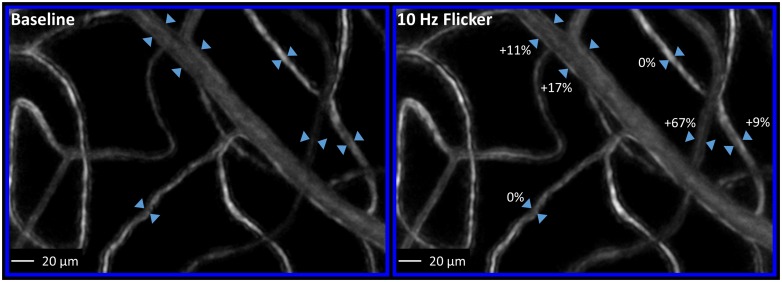
Example of a region of interest (from participant shown in Fig 1) following baseline and flicker conditions.Each region of interest was selected to contain a ‘major’ vessel and associated capillary branches. This particular region contains a venule. Note the stability in depth of focus across both conditions. To facilitate visualization of changes between pre- and post-flicker conditions for this region, see supplementary material S1 Video.